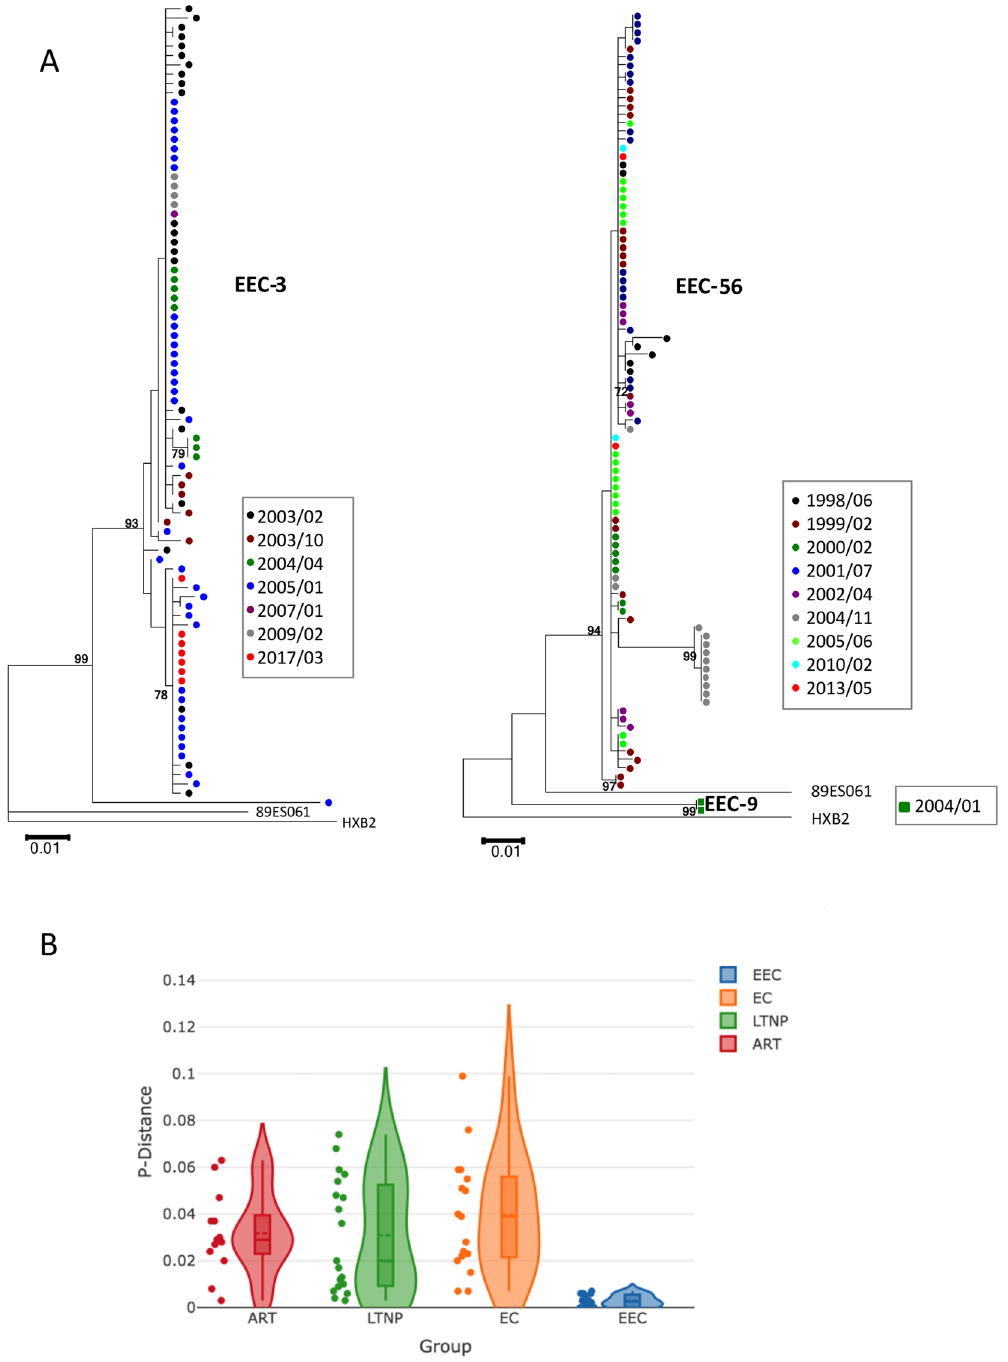
Figure 2. Genetic variability and evolutionary dynamics of viral populations ( A ) Phylogenetic trees with env gene sequences of the individuals during follow-up. The evolutionary history was inferred in trees by using the Maximum Likelihood method based on the General Time Reversible model. The percentage of trees in which the associated taxa clustered together with values over 70% is shown next to the branches. Initial tree for the heuristic search was obtained by applying the Neighbor-Joining method to a matrix of pairwise distances estimated using the Maximum Composite Likelihood approach. A discrete Gamma distribution was used to model evolutionary rate differences among sites (4 categories). The tree is drawn to scale, with branch lengths measured in the number of substitutions per site. Evolutionary analyses were conducted in MEGA6. Different colors were used to indicate the sampling time. ( B ) Genetic variability analysis of samples from different groups of HIV-1 individuals with a controlled infection (see Materials and